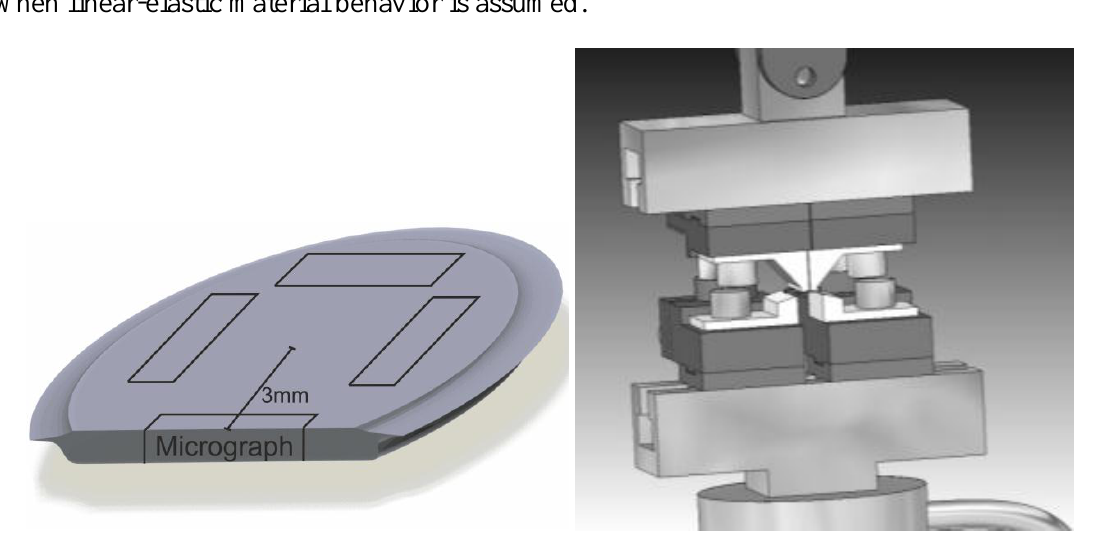
Figure 1. ( a ) HPT disc with indicated specimen extraction areas. ( b ) cyclic four-point-bending test